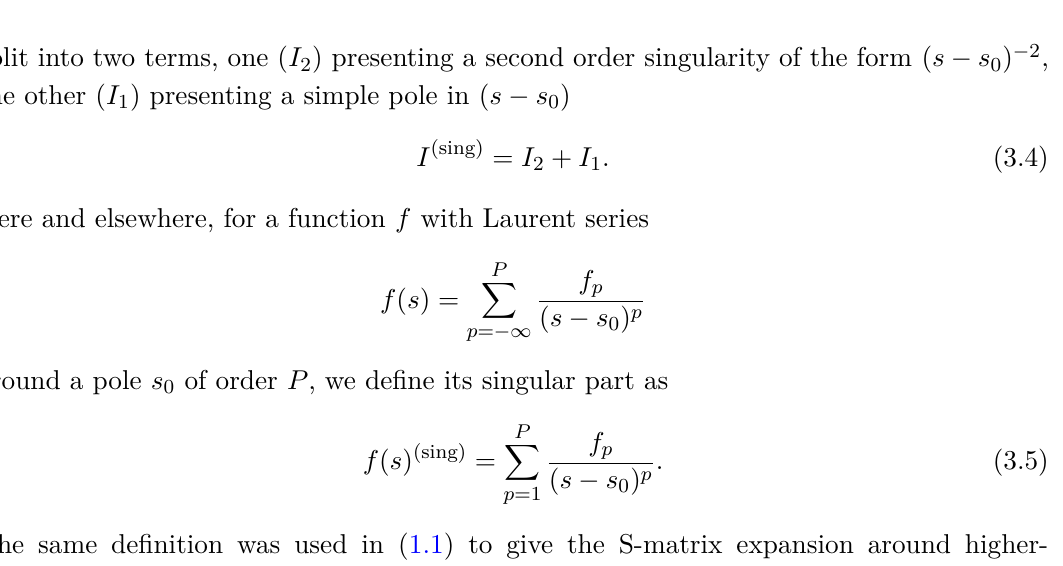
Figure 3 . The box diagram lying in the Euclidean slice of the space of complex energy and